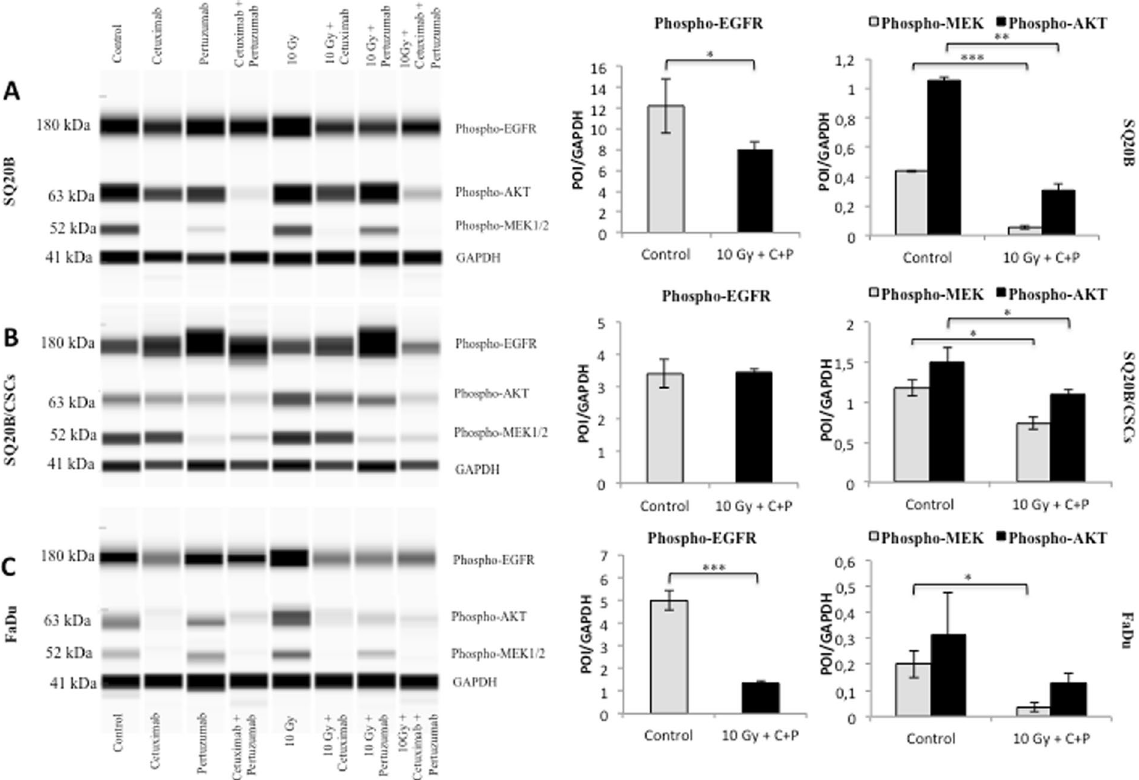
Figure 5. Treatment impact on protein expression . The expression of phospho-EGFR (Tyr1068) (182 kDa), phospho-AKT (Ser473) (63 kDa) and phospho-MEK1/2(Ser217/221) (52 kDa) was evaluated under the following treatment conditions: control; cetuximab 5 nM; pertuzumab 20 μ g/mL; cetuximab 5 nM + pertuzumab 20 μ g/mL; 10 Gy; 10 Gy + cetuximab 5 nM; 10 Gy + pertuzumab 20 μ g/mL; 10 Gy + cetuximab 5 nM + pertuzumab 20 μ g/mL. Ratios of phospho-EGFR, phospho-AKT and phospho-MEK to GAPDH expression (41 kDa) were calculated and are graphed as (protein-of-interest (POI)/GAPDH). ( A ) SQ20B. ( B ) SQ20B-CSCs. ( C ) FaDu. Statistically significant differences are expressed as * p < 0.05, ** p < 0.01 and *** p < 0.001. Each experiment was performed in